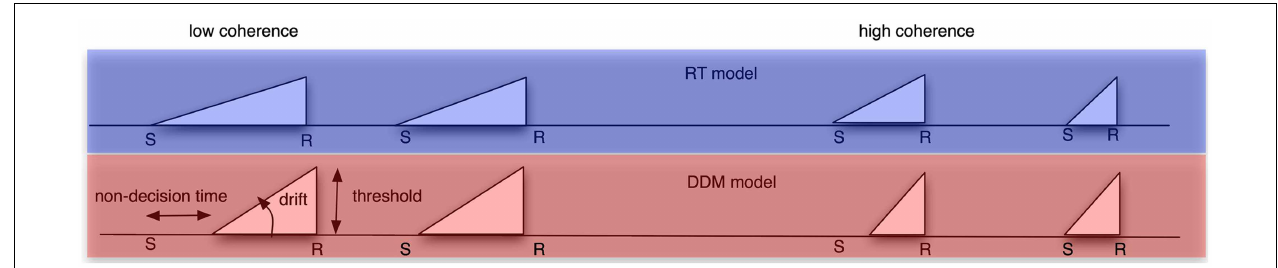
coherence condition. Conversely, the DDM model has a fixed shape for all trials within the low-coherence condition, and another shape for all trials within the high-coherence condition.This shape is determined by three DDM parameters: non-decision time (which determines ramp onset), decision threshold (which determines ramp height) and drift rate (which determines the slope of the ramp).